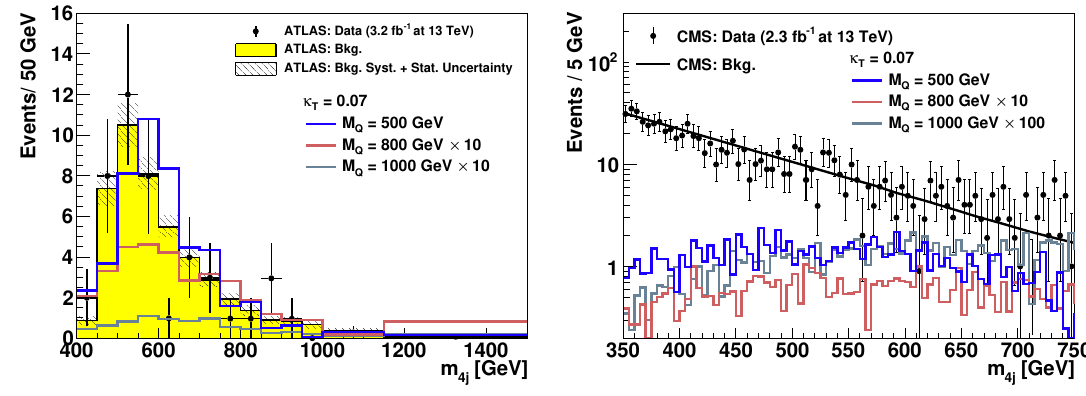
Figure 6 . Distribution in the invariant mass of the reconstructed di-Higgs system both for the resolved ATLAS-like analysis (left) and CMS-like analysis (right). We select three benchmark setups with VLQ masses of 500 GeV (blue), 800 GeV (red) and 1 TeV (grey) and with (cid:20) T = 0 :